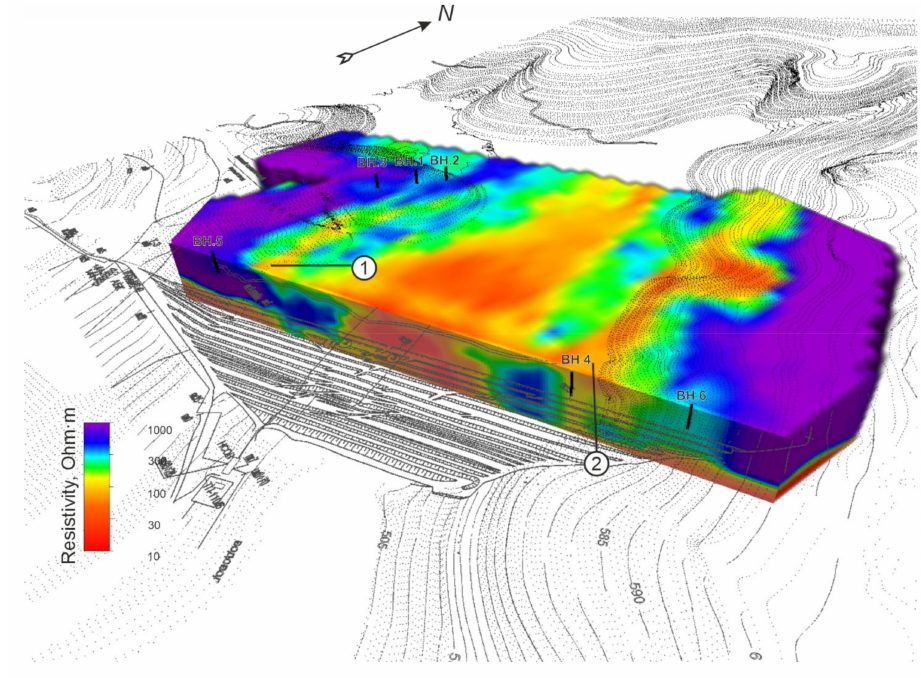
Figure 10. Volumetric geoelectric model of the research site: 1—filtration along the fault in the right-bank (western) junction; 2—the same in the left-bank (eastern)